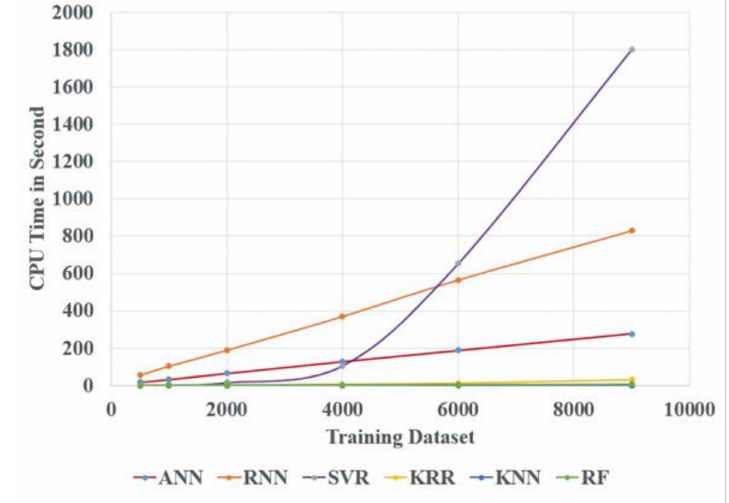
Figure 19. CPU time vs. training dataset for different AI